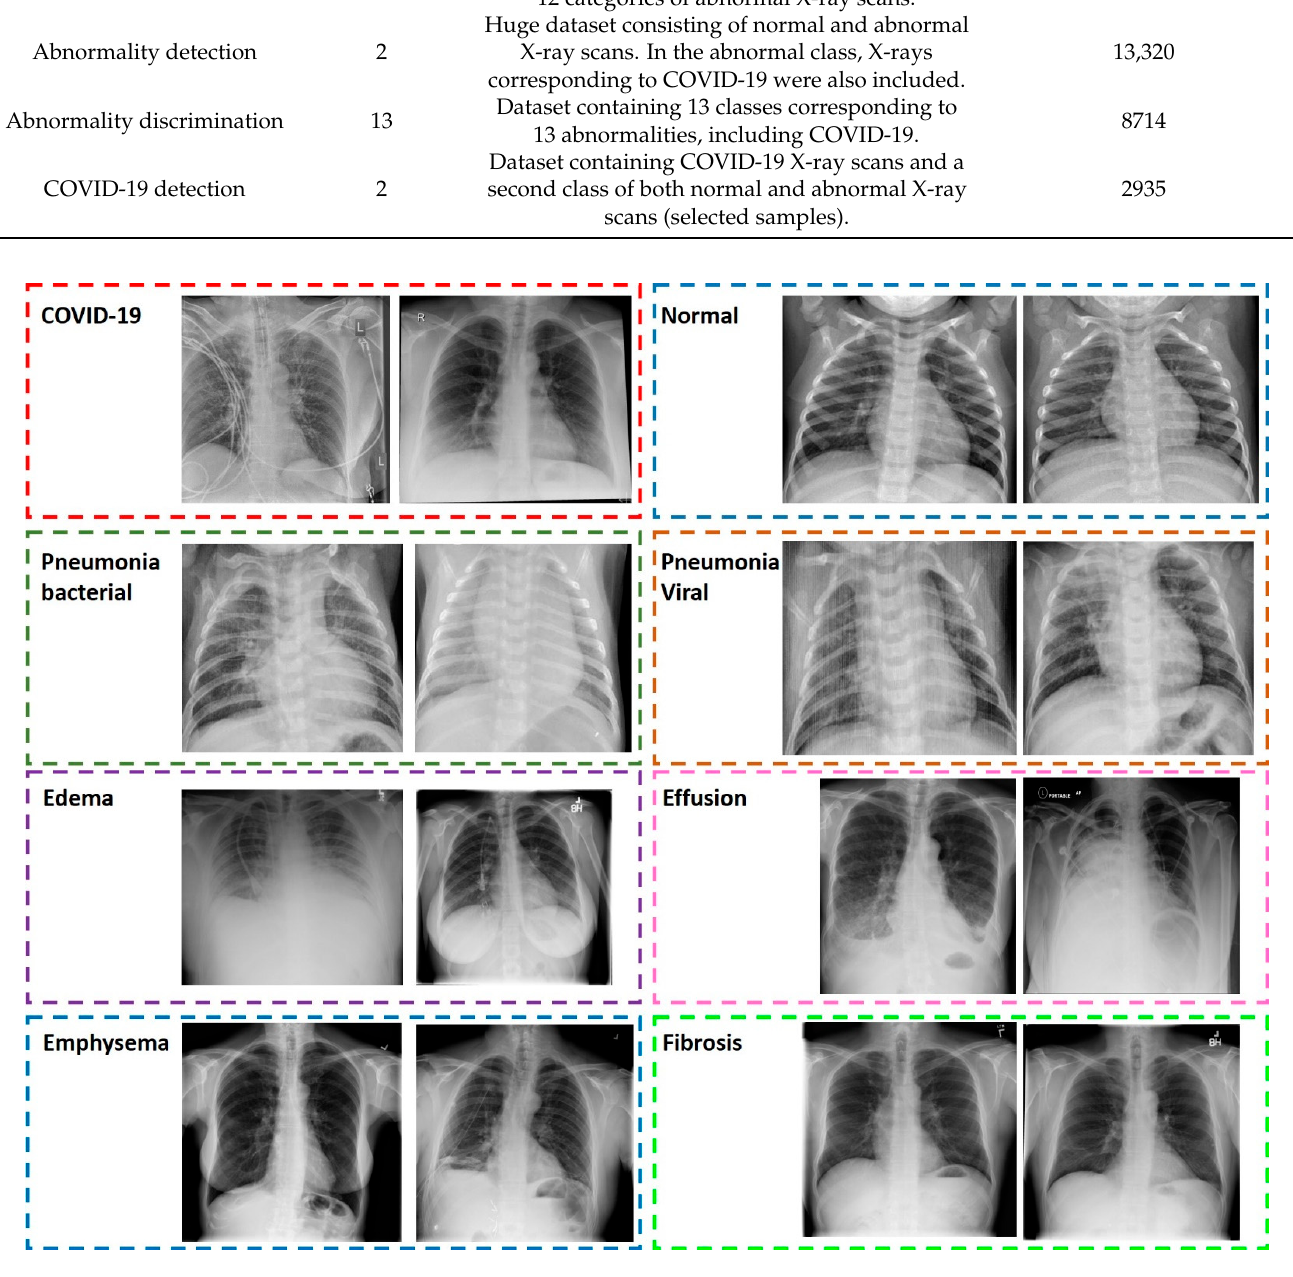
Table 1. Characteristics of the dataset.